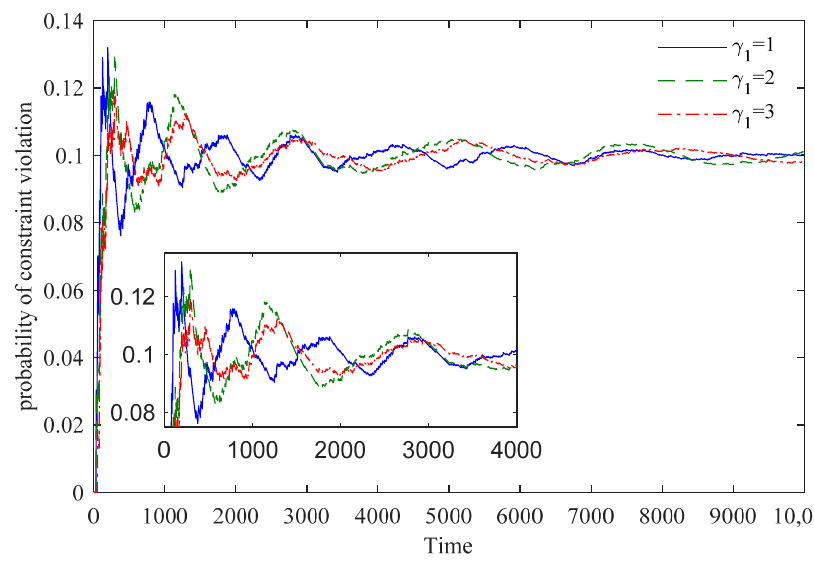
Figure 9. Comparison of constraint violation probabilities with different constraint update parameter γ 1 ( T = 8, γ 2 = 0.1).